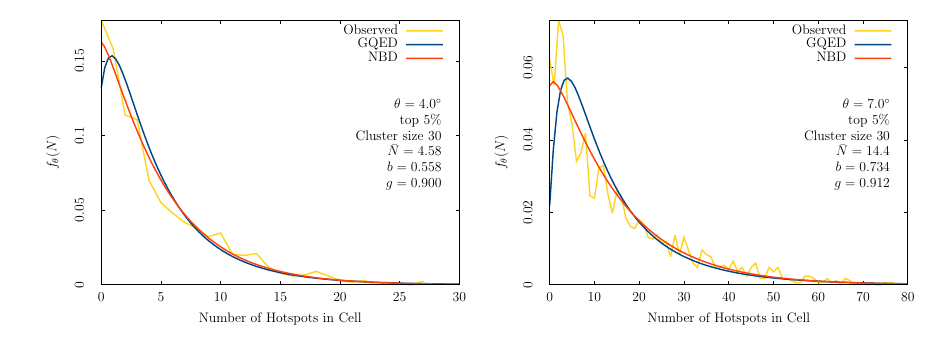
Figure 1. Comparison between NBD and GQED for cell sizes of 4 . 0 ◦ and 7 . 0